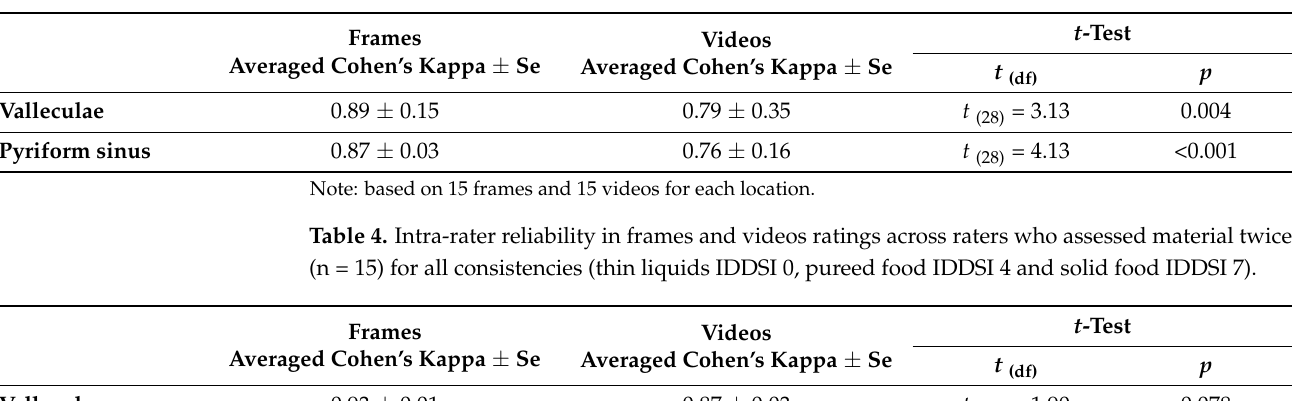
Table 3. Construct validity in frames and videos ratings across all raters (n = 29) for all consistencies